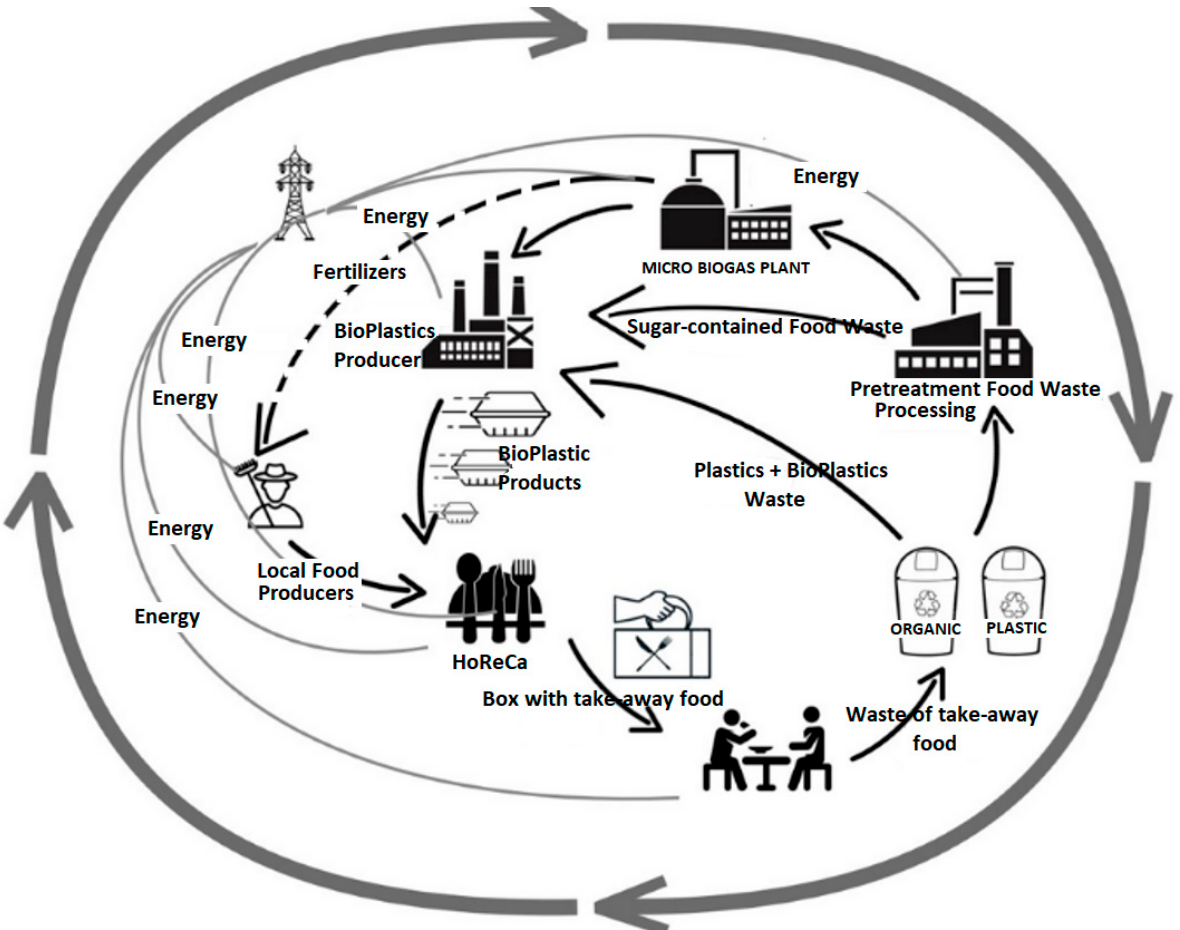
Figure 1. Circularity in the life cycle of take-away food packaging. Source: Authors’.